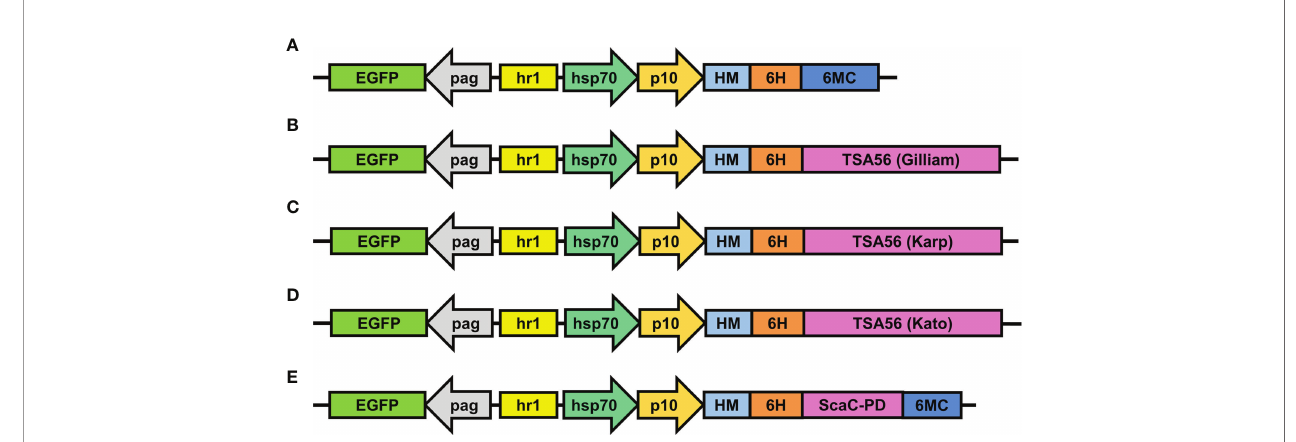
FIGURE 2 | Schematic illustrations of transfer vectors used to construct recombinant baculoviruses. (A) The empty vector pAB-pEG-hhp10-HM-6H-6MC prior to TSA56 or ScaC -PD gene insertion. TSA56 from the Gilliam, Karp, or Kato strains, or ScaC -PD from Gilliam, were inserted into the vector, generating pAB-pEG- hhp10-HM6H-Gilliam (B) , pAB-pEG-hhp10-HM6H-Karp (C) , pAB-pEG-hhp10-HM6H-Kato (D) , and pAB-pEG-hhp10-HM6H-ScaC-PD-6MC (E) , respectively. EGFP, EGFP reporter gene; pag, pag promoter; hr1, homologous region; hsp70, heat shock protein 70 promoter; p10, p10 promoter; HM, honeybee melittin signal peptide; 6H, hexameric histidine tag; 6MC, transmembrane domain and cytoplasmic-tailed domain of baculovirus GP64